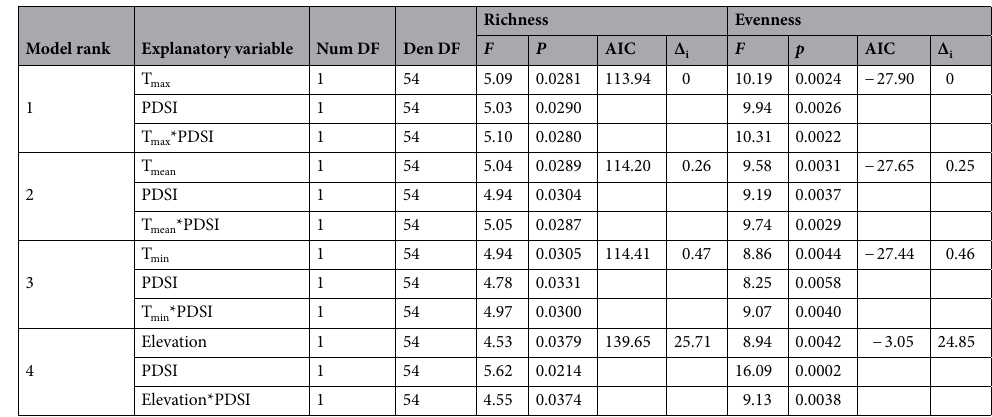
Table 2. Model results of the generalized linear mixed model analysis with species richness (number of observed ASVs) and evenness (inverse Simpson index) as dependent variables and elevation, Palmers drought